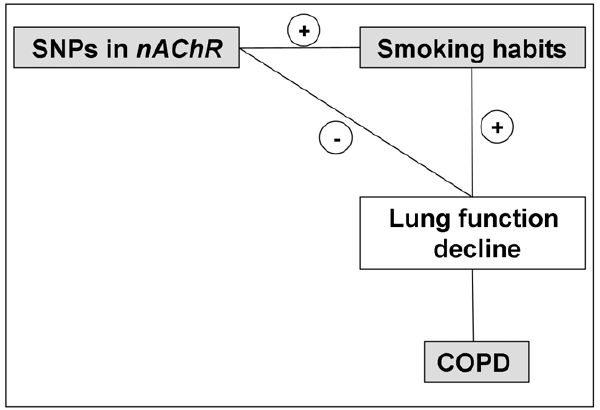
Figure 2. Summary of the observed associations in the current study. SNPs=single nucleotide polymorphisms; COPD=Chronic Ob- structive Pulmonary Disease; nAChR = nicotinic acetylcholine receptor ; + =association; 2 =no association. doi:10.1371/journal.pone.0033386.g002 PLoS ONE |